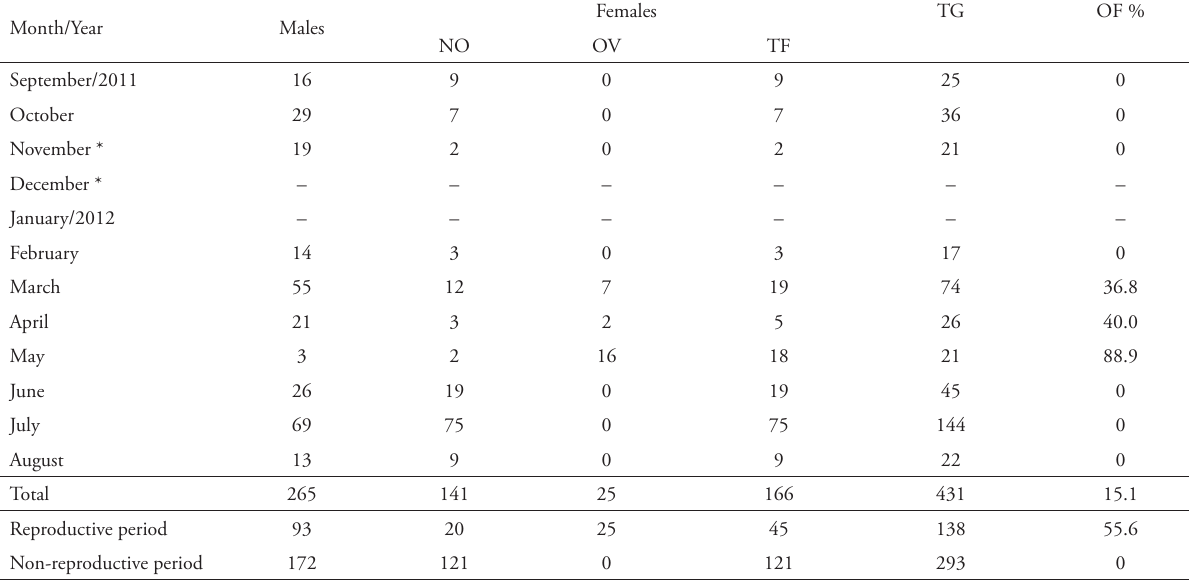
Table 1. Ucides cordatus (Linnaeus, 1763). The absolute abundance (number of individuals) by sex and population groups in the mangrove areas of the Joanes River, Lauro de Freitas municipality (Bahia State, Brazil), captured monthly between September 2011 and August 2012, with respect to the biological period (reproductive: December to May; non-reproductive: June to November). NO indicates females without eggs, OV indicates ovigerous females, TF indicates total number of females, TG indicates total number of crabs (males + females), and OF% indicates the percentage of ovigerous females of all total